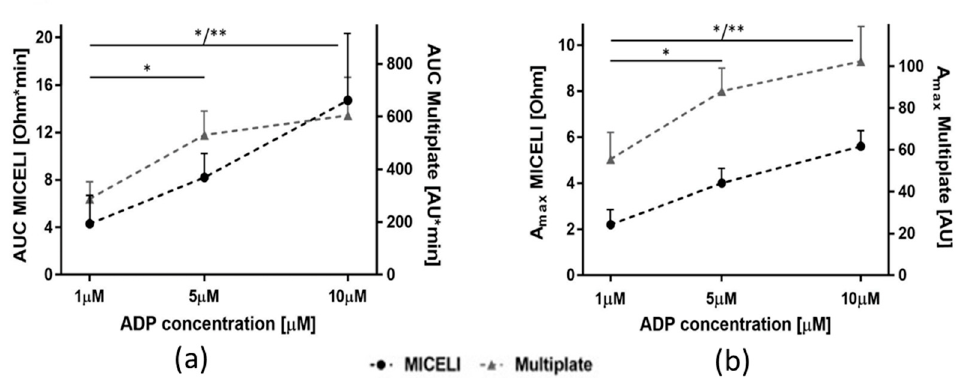
Figure 8. Comparison of aggregation parameters of ADP-induced platelet aggregation recorded by the MICELI aggregometer and Multiplate ® Analyzer. Platelet aggregation in hirudin-anticoagulated whole blood was induced by 1, 5, or 10 µ M ADP: ( a ) area under the curve (AUC); ( b ) maximum aggregation (Amax). Data from 6 independent experiments using blood samples from 6 different individuals are reported. Mean ± SD as error bars of aggregation parameters are indicated, ANOVA: no asterisk— p > 0.05; * p < 0.05; ** p < 0.01.